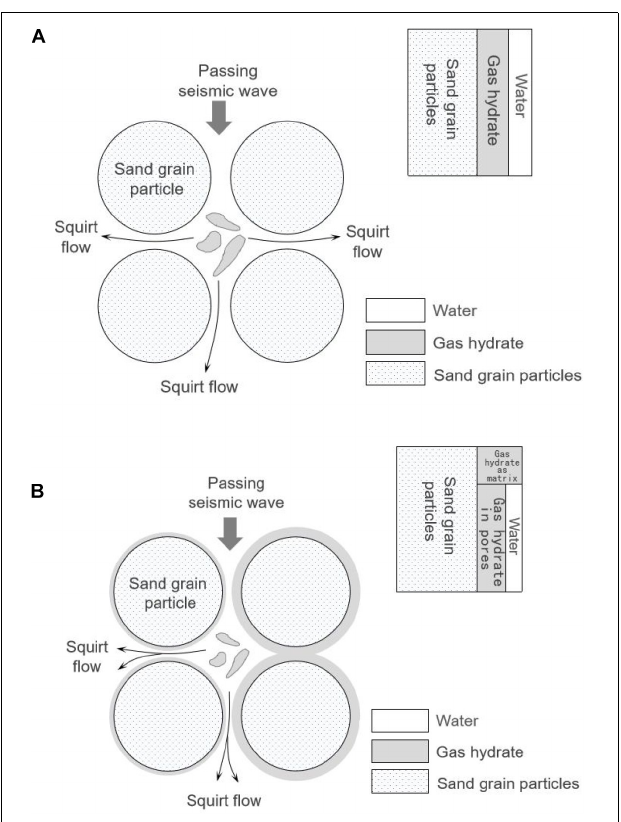
FIGURE 1 | Schematics of the gas hydrate concentration in different ways. (A) Pore filling and (B) the co-existence of pore filling and particle